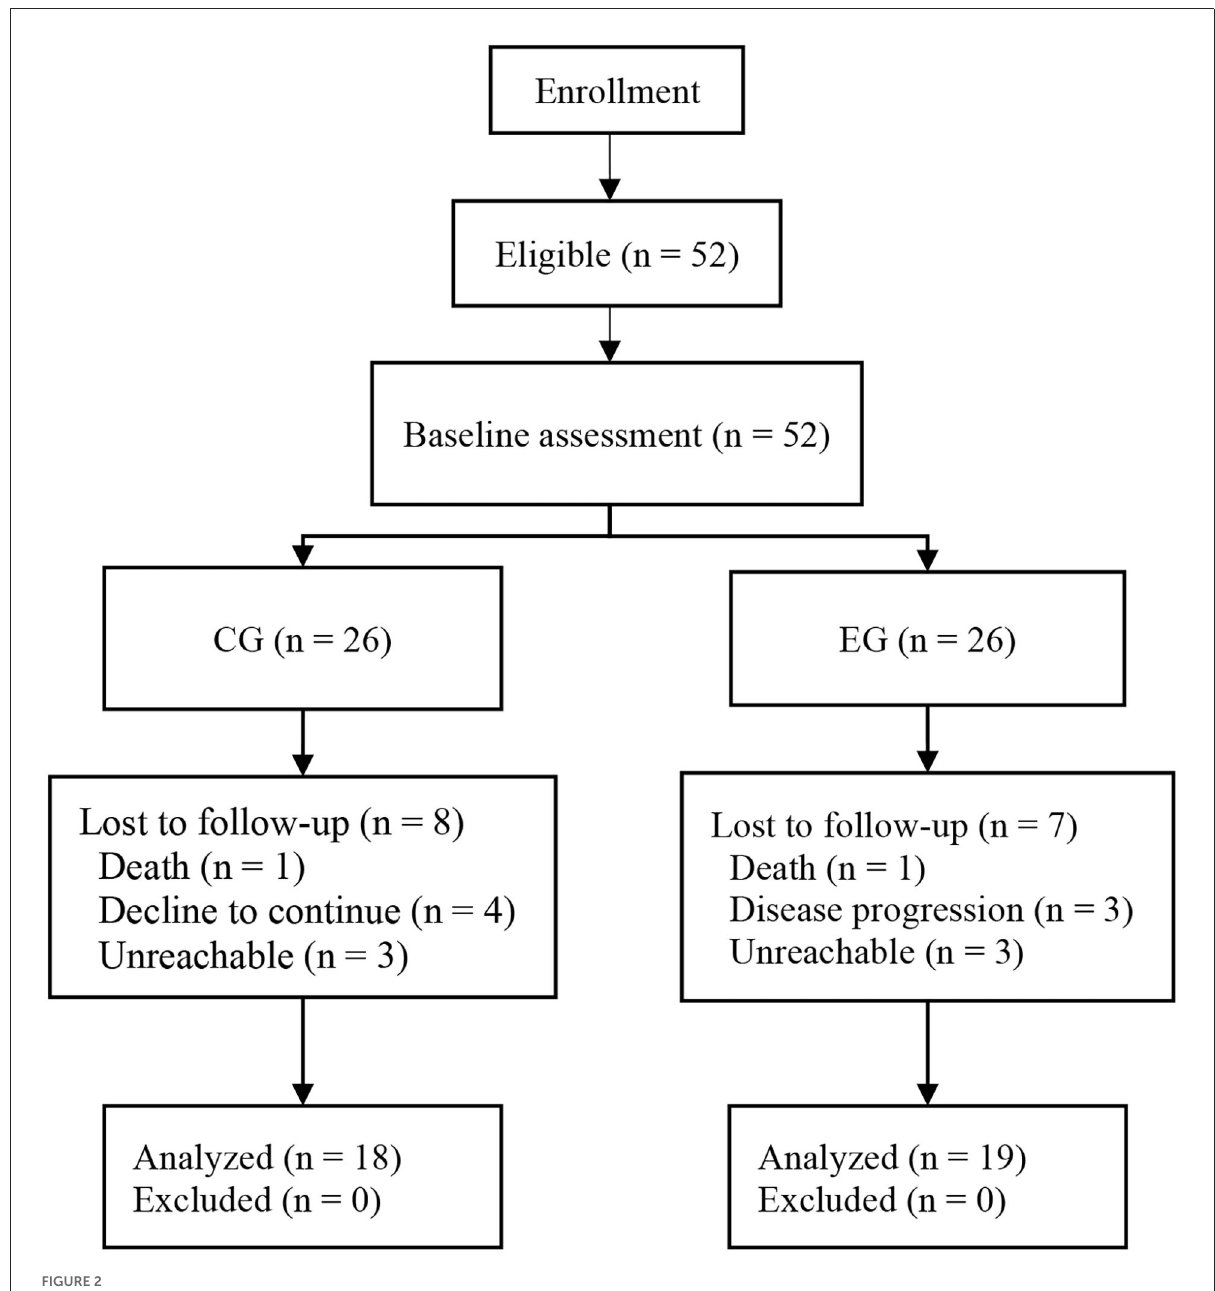
FIGURE2 Flowchart of the